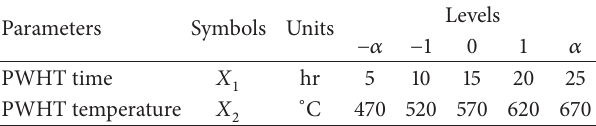
Table 4: Matrix of PWTH parameters and response factor in tensile